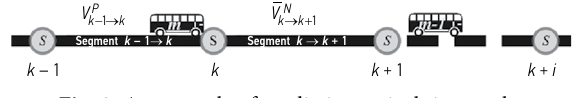
Fig. 2. An example of predicting arrival time at the immediate downstream stop